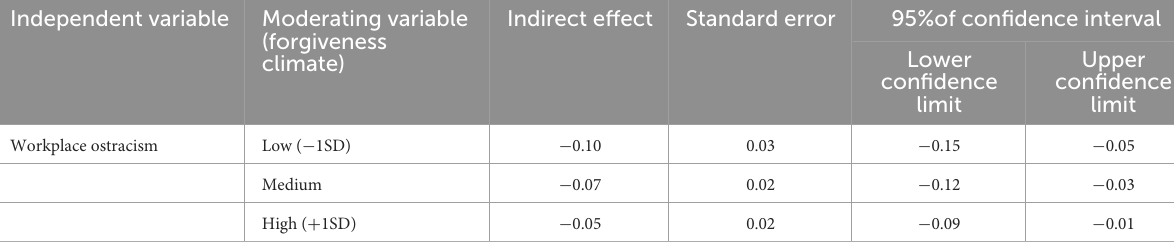
TABLE 6 Bootstrap test for mediating effects with